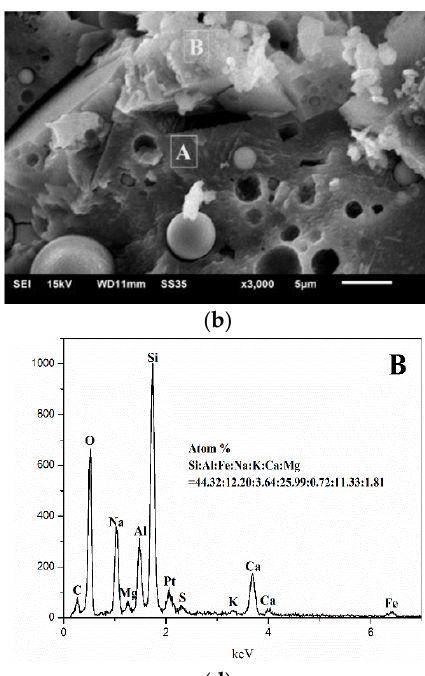
Figure 6. Pore size distribution of FA-based geopolymer grouting materials: ( a ) differential curves of pore size distribution; ( b ) proportion of pores.